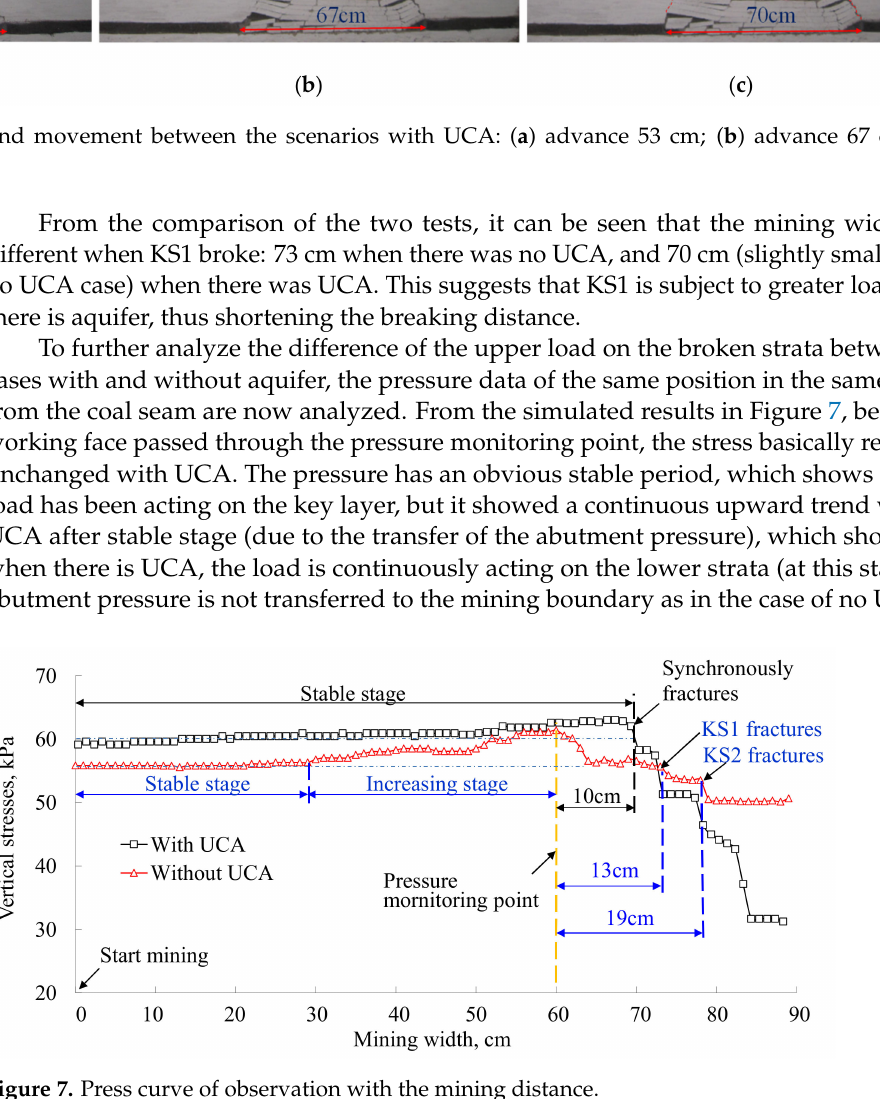
Figure 7. Press curve of observation with the mining